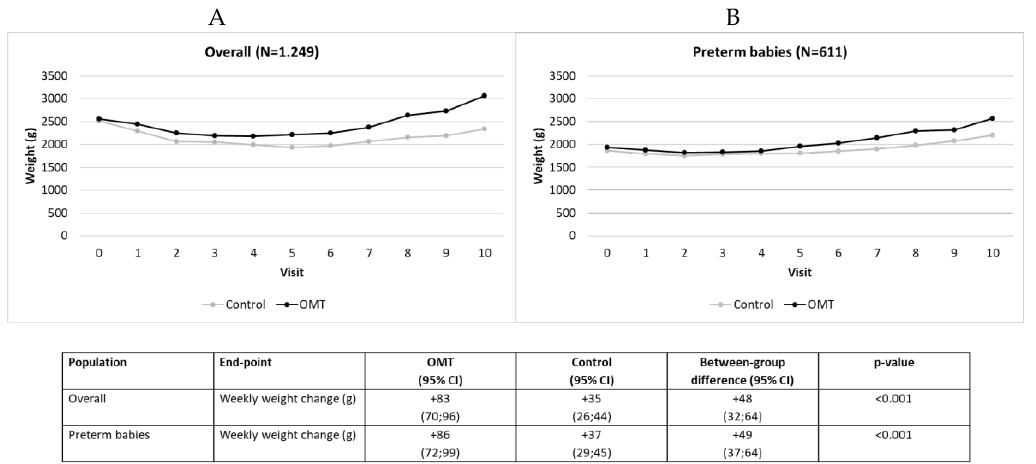
Figure 1. ( A ) Weight change over time in the overall cohort. ( B ) Weight change over time in the subgroup of preterm babies. Figure 1. A. Weight change over time in the overall cohort. Figure 1B. Weight change over time in the subgroup of preterm babies.